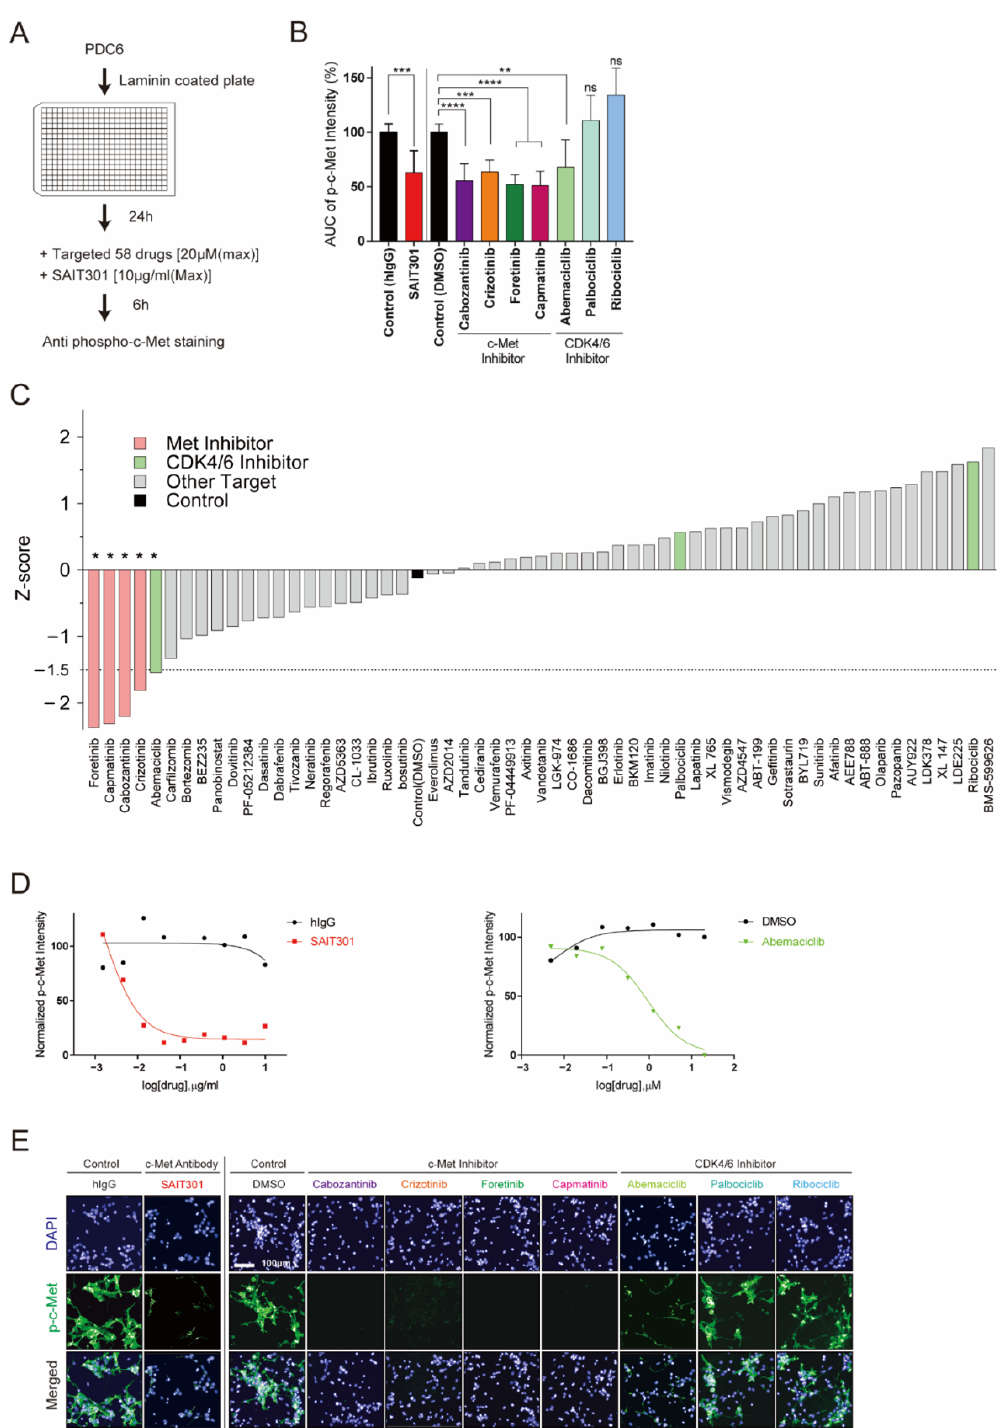
Figure 3. Drug repurposing screen identifies abemaciclib as an inhibitor of c-Met. ( A ) Overview of the drug repurposing screen. PDC6 were treated with 58 targeted agents and SAIT301, and image-based p-c-Met fluorescence assay was performed. ( B ) AUC was obtained from DRC of p-c-Met assay. Representative graph shows AUC of SAIT301 and four known c-Met-targeting inhibitors and three CDK4/6 inhibitors (****: p < 0.0001, ***: p < 0.001, **: p < 0.01, *: p ≤ 0.05, ns: p > 0.05, not significant). ( C ) Z-score of DMSO and 58 drugs for p-c-Met screen. ( D ) DRC of normalized p-c-Met intensity for SAIT301 (left) and abemaciclib (right). ( E ) Fluorescence images of DAPI (blue) and p-c-Met (green) in PDC6 treated with SAIT301(10 µ g/mL), four known c-Met-targeting inhibitors (20 µ m), and three CDK4/6 inhibitors (20 µ